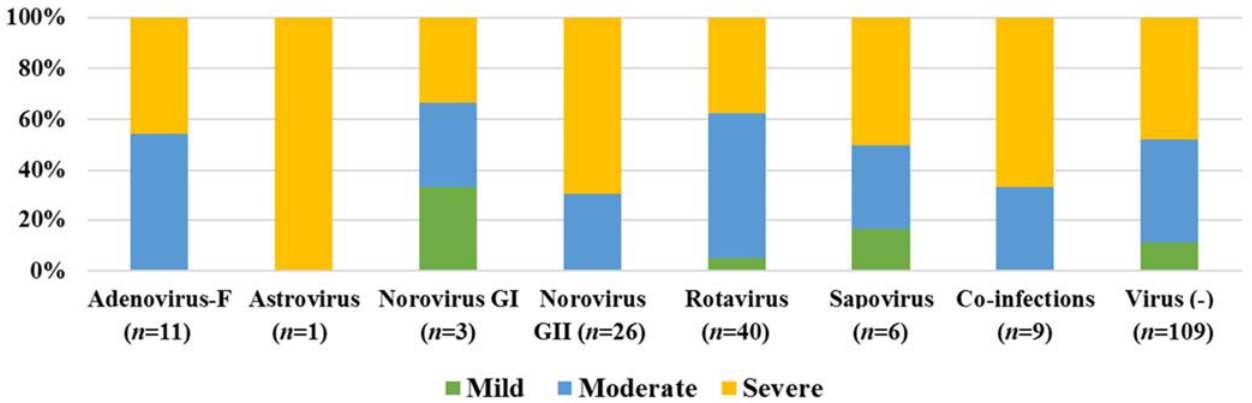
Figure 2. Disease severity observed during gastroenteritis virus infections (96) and virus unrelated gastroenteritis episodes (109) in children ≤ 5 years, hospitalised with gastroenteritis at KPTH from July 2016 to December 2017.